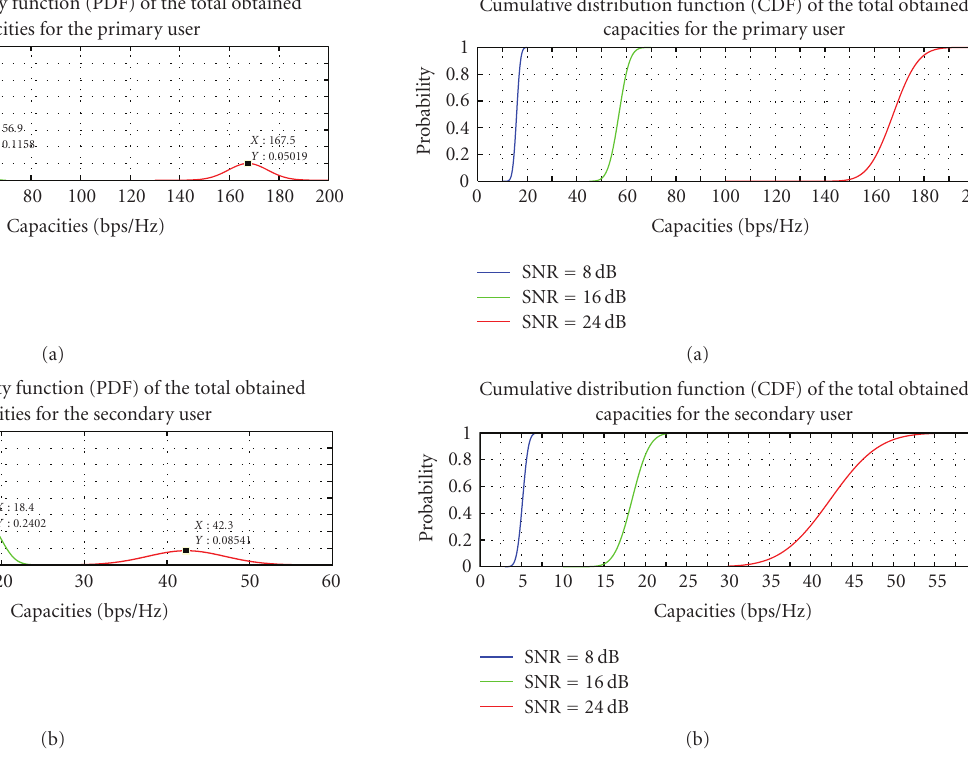
Figure 6: CDFs of the total obtained capacities (primary/secondary user), SNR = 8dB, 16 dB, and 24 dB.